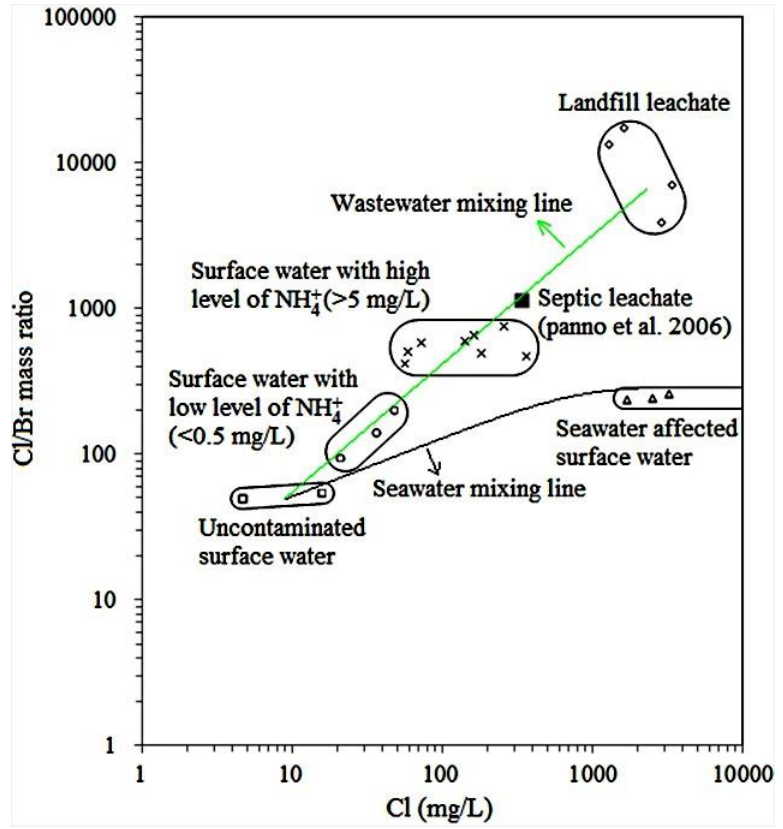
Figure 2. Plot of Cl/Br mass ratios versus Cl concentrations in surface waters in the Pearl River Delta. Also shown are a seawater mixing line between uncontaminated surface water and seawater-affected surface water, a wastewater mixing line linearly connecting uncontaminated surface water, surface water with a low level of NH 4 + , surface water with a high level of NH 4 + , septic leachate [17], and landfill leachate.